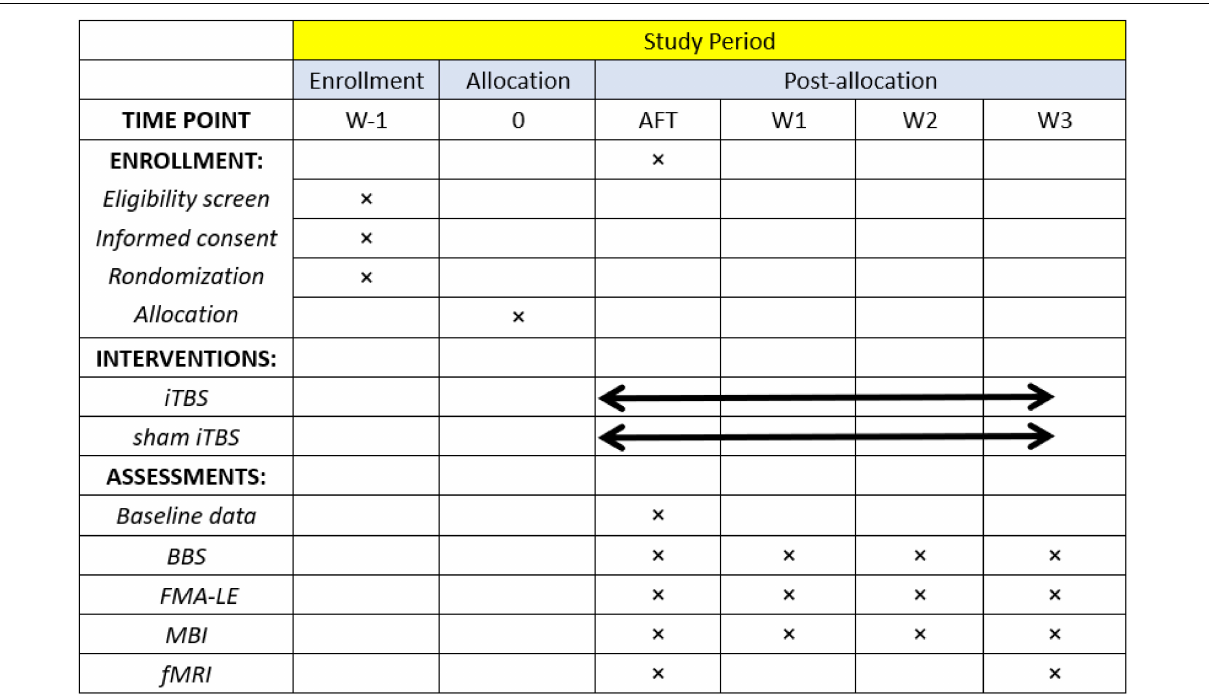
software (DPARSF 2 ) will be used for data processing and